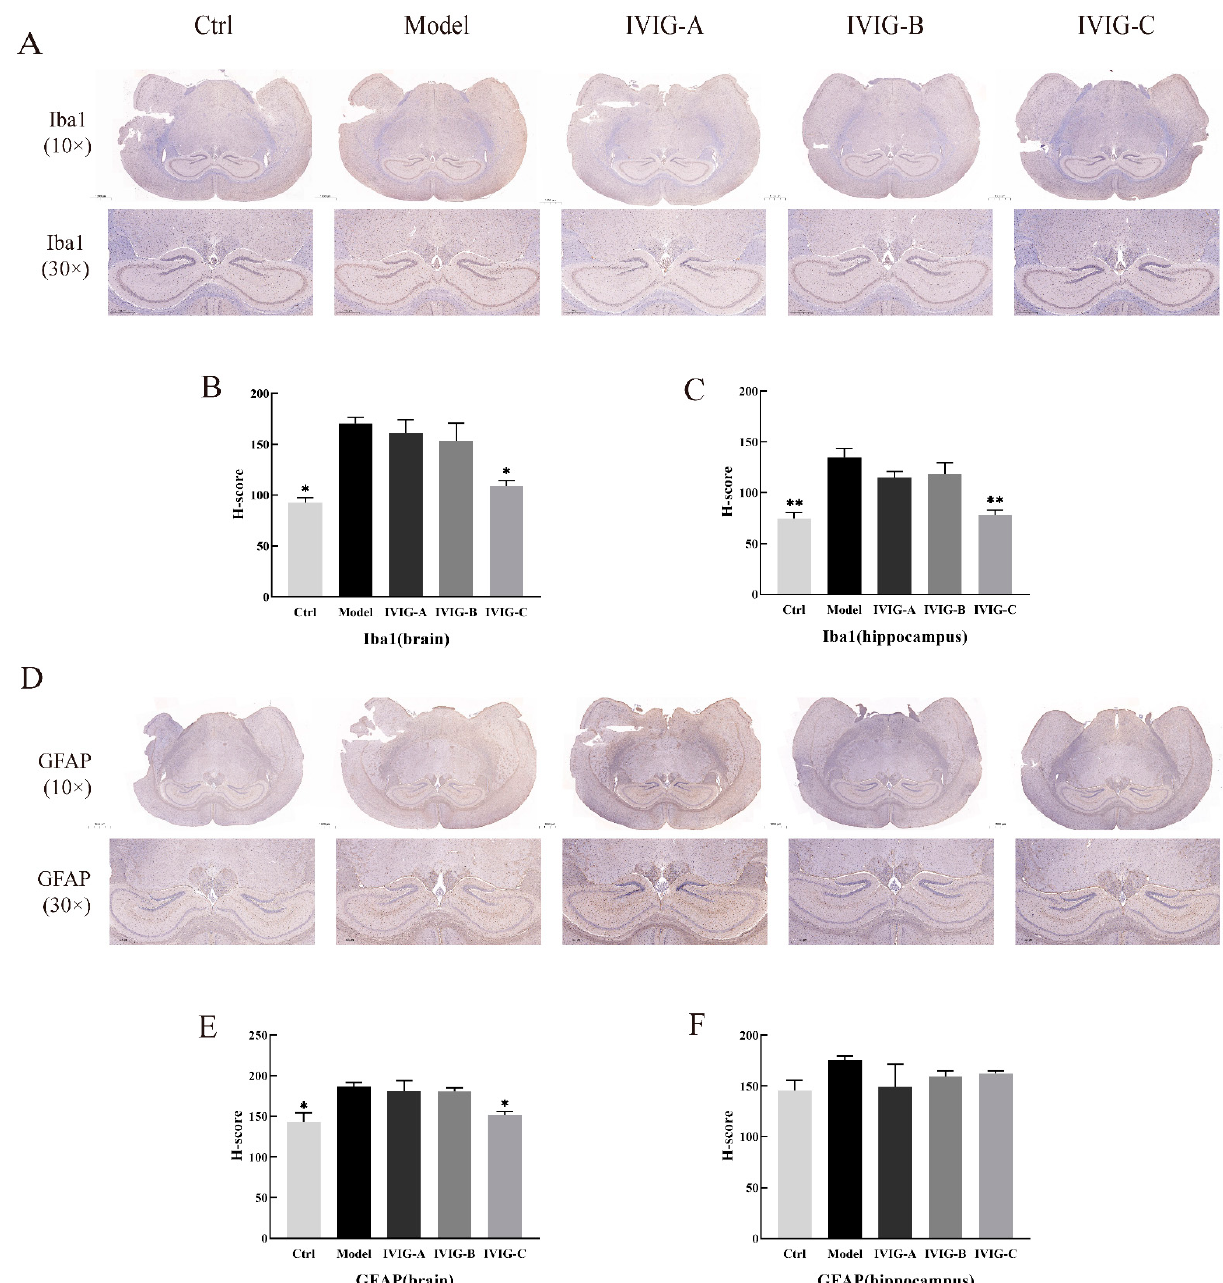
Figure 4. ( A ) Iba1-positive cells in the brain and hippocampus. H-score was used to grade the percentage of IBA-1 positivity in the brain ( B ) and hippocampus ( C ). IVIG-C reversed the increase of IBA-1 positive cells in the brain and hippocampus of mice induced by LPS. ( D ) GFAP-positive cells in the brain and hippocampus. H-score was used to grade the percentage of GFAP positivity in the brain ( E ) and hippocampus ( F ). IVIG-C reversed the increase of IBA-1-positive cells in the brain of mice induced by LPS. Ctrl, control group; Model, LPS injection (Model) group; Data are expressed as the mean ± SEM. Statistical significance using one-way ANOVA defined as * p < 0.05, ** p < 0.01 vs. Model group ( n =